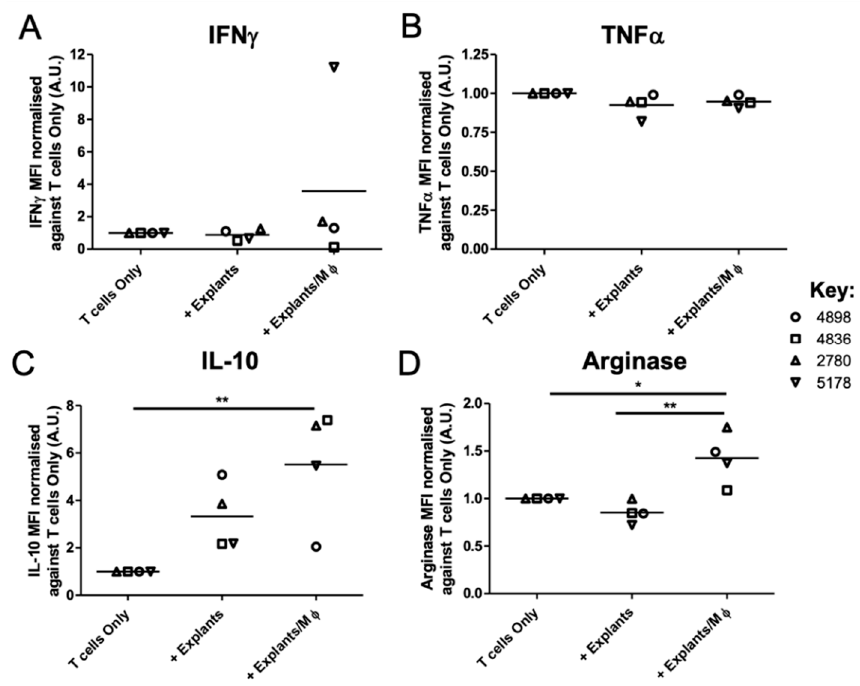
Figure 5. Tumour-conditioned M φ s contribute to the development of an immunosuppressive lung tumour microenvironment ex vivo. NSCLC explants were co-cultured with autologous patient CD14 + PBMCs for 48 h to enable macrophage polarisation. Explant only wells were established to assess soluble factor secretion from tumour-associated M φ s and other tumour microenvironment components. Tumour cultures were loaded with 5 µ g/mL viral peptide pool prior to the addition of T cells. T cell co-cultures were incubated for 6 days. Supernatants were harvested from each culture condition and a Human Macrophage/Microglia LEGENDplex TM bead-based immunoassay was used to quantify the levels of 13 soluble factor targets released from the T cell co-culture system. The mean fluorescence intensity (MFI, A.U.) values for ( A ) IFN γ , ( B ) TNF α , ( C ) IL-10, and ( D ) arginase, are shown. Values normalised against T cell Only outputs. Each symbol represents an individual patient ( n = 4 NSCLC patients). The p values were obtained from one-way ANOVA followed by post hoc Tukey test. Statistically significant differences were observed compared to all experimental arms. Data are pooled from 4 independent patient experiments and graphs show means ± SEM. * p < 0.05, ** p <